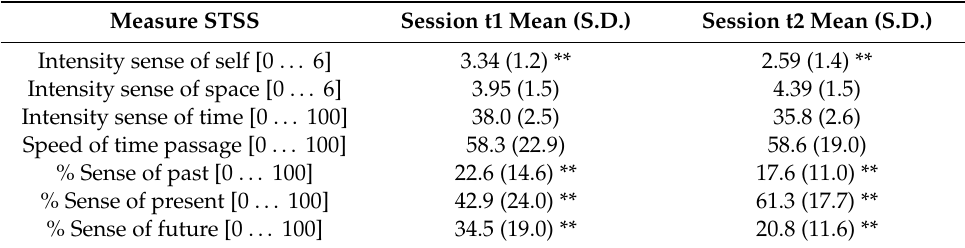
Table 2. Mean (S.D.) values for the conscious state inventory on subjective time, self, space (STSS) for the two sessions (t1, t2), regardless of whether mindfulness meditation or the fantasy relaxation was conducted. Measure STSS Session t1 Mean